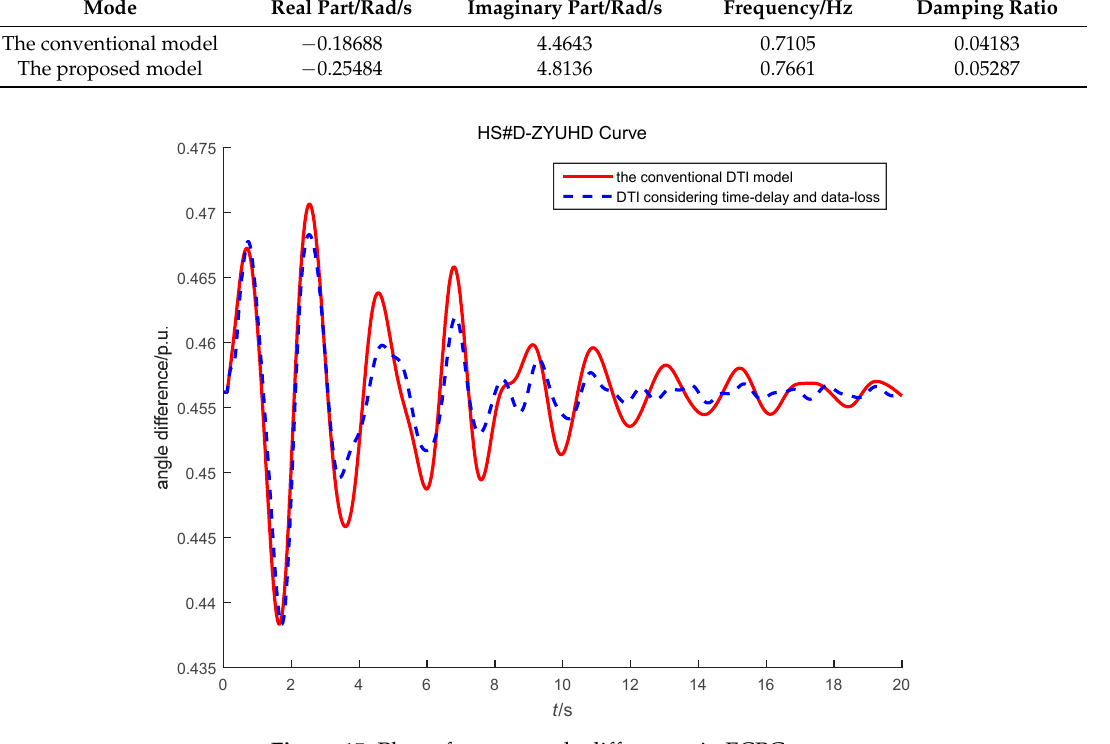
Figure 15. Plots of power angle differences in ECPG.